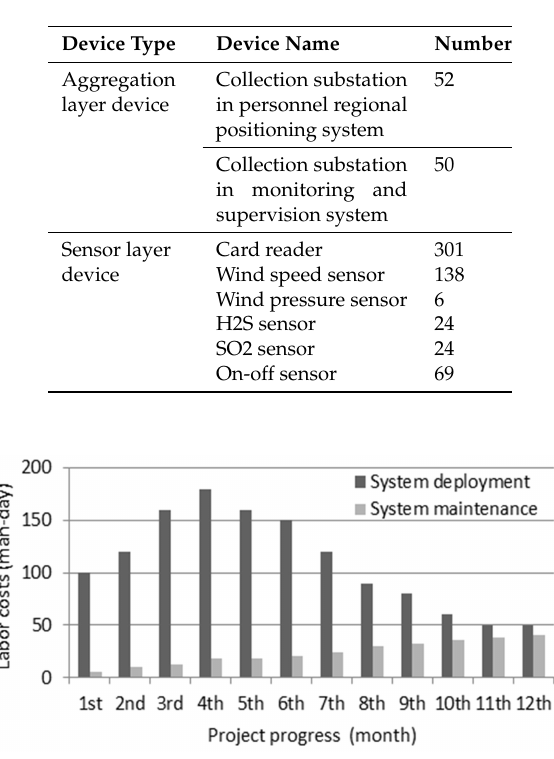
Table 1. Devices used in the Fankou Six System.